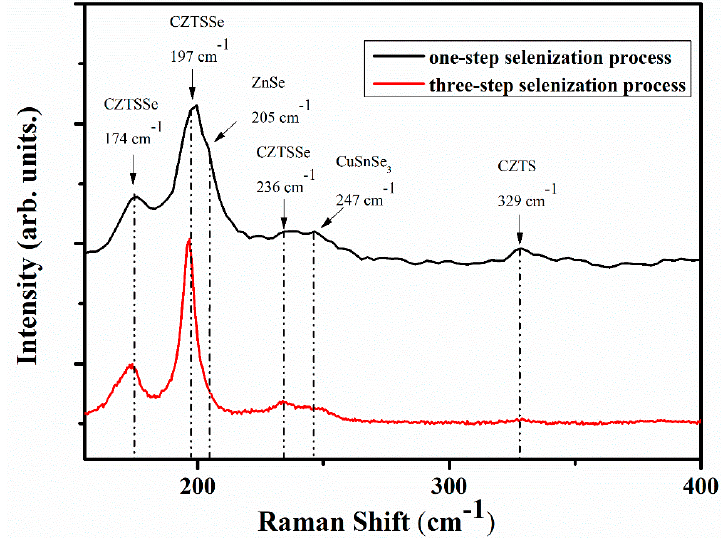
Figure 3. Raman spectrums of CZTSSe film with the one-step and three-step selenization process.